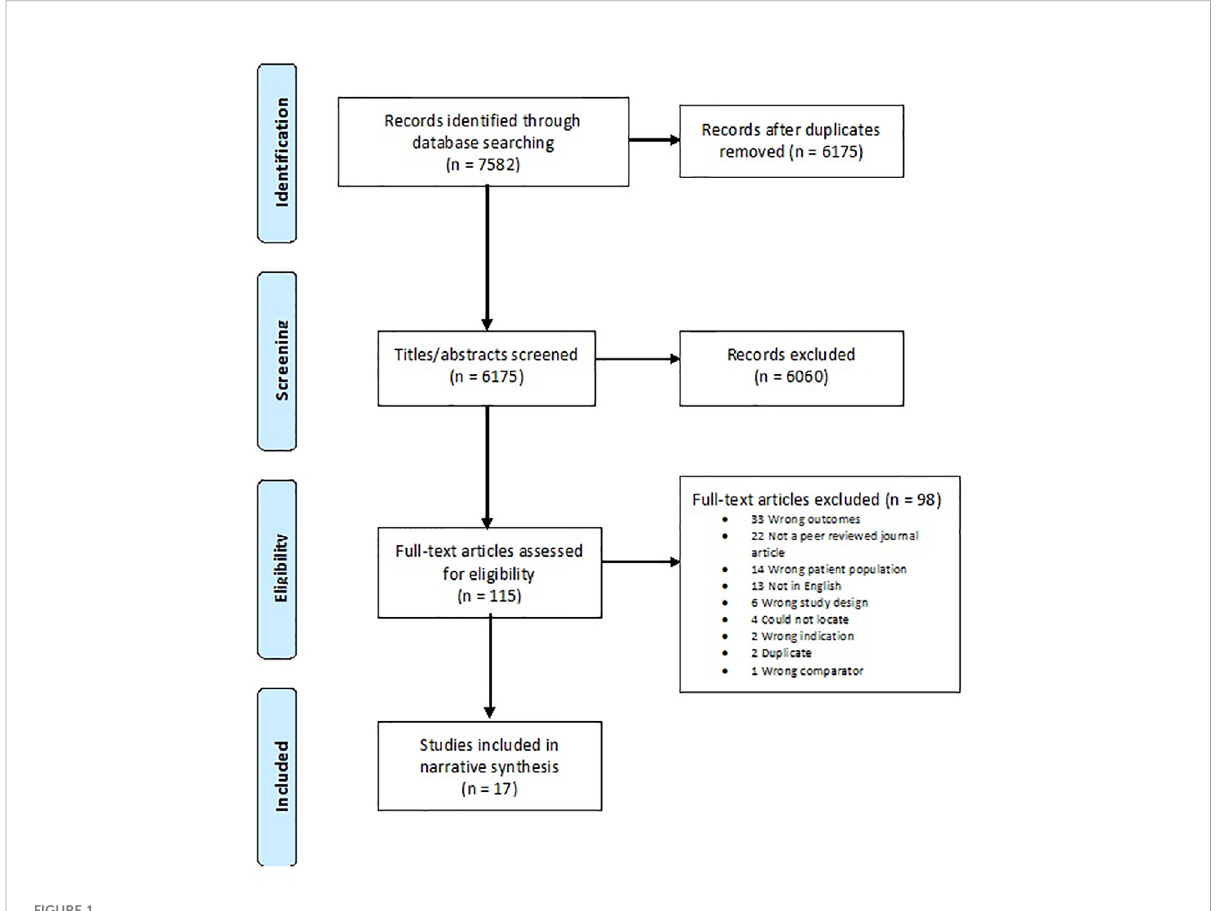
FIGURE 1 PRISMA